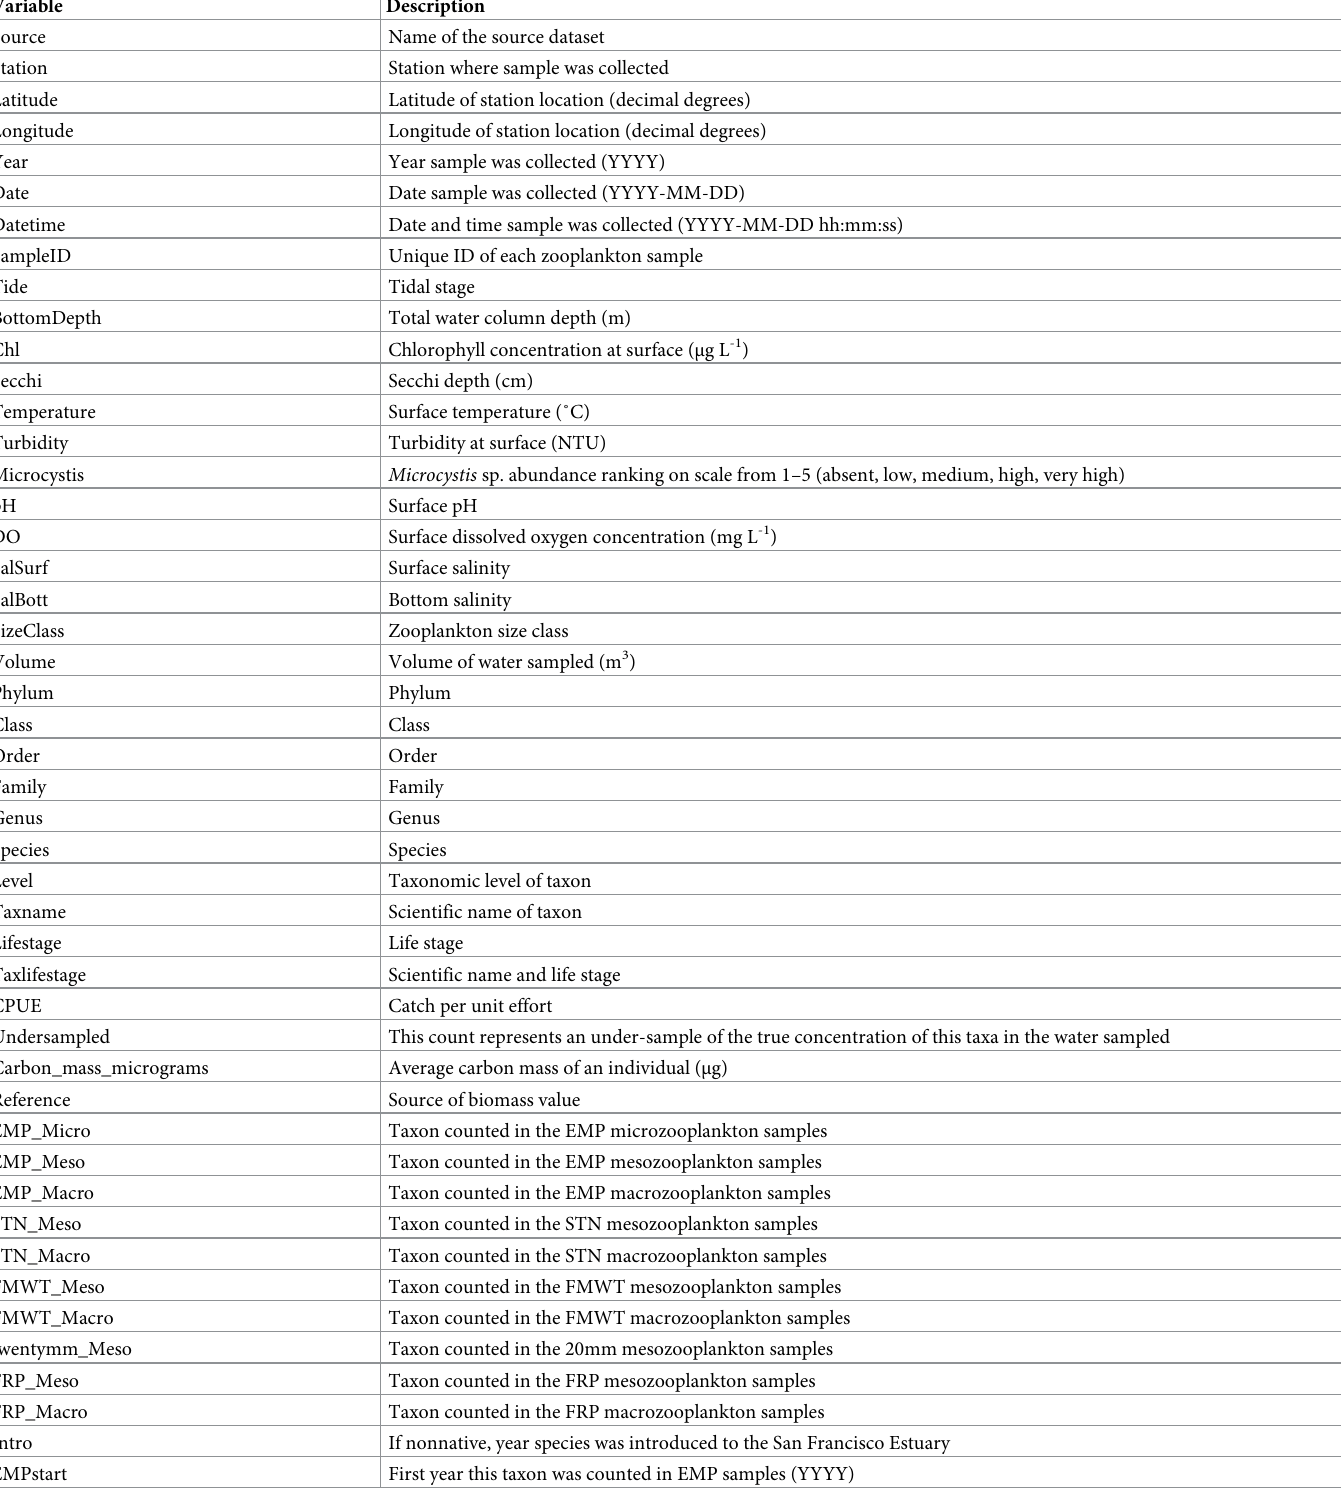
Table 3. Descriptions of variables in the zooplankton data